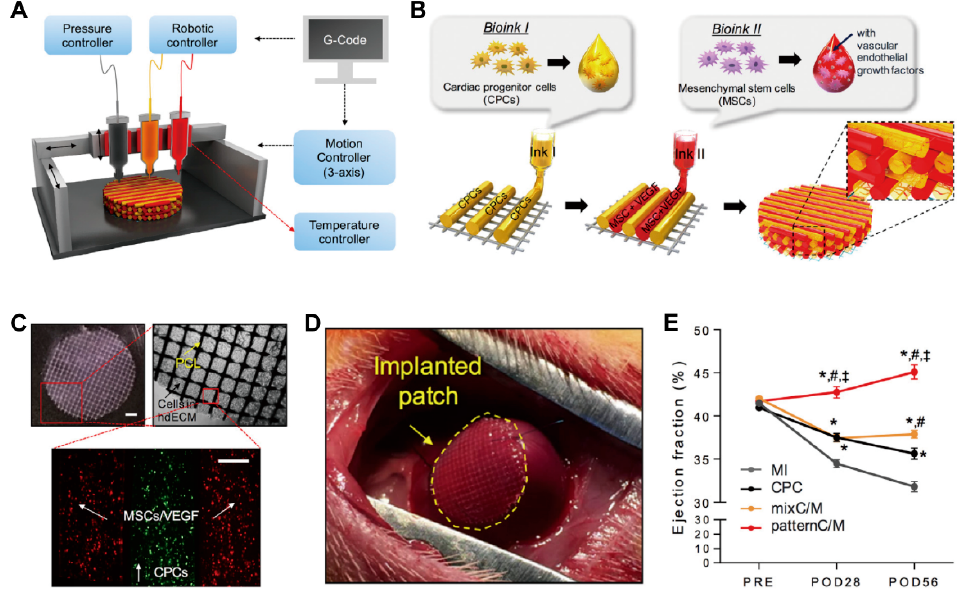
Figure 16. Schematic illustration of 3D cell printing system ( A ), pre-vascularized stem cell patch including cell-laden bioinks and PCL polymer ( B ). Representative images of fabricated patch ( C ) and implanted patch on the epicardium of rat myocardial infraction (MI) model ( D ). ( E ) Ejection fraction values after four and eight weeks (* p < 0.05 compared with MI; # p < 0.05 compared with CPC; ‡ p < 0.05 compared with mixC/M). Scale bar: 1 mm for left top of ( C ) and 200 μ m for bottom of ( C ). Reprinted from [115]. Copyright (2016) Elsevier.